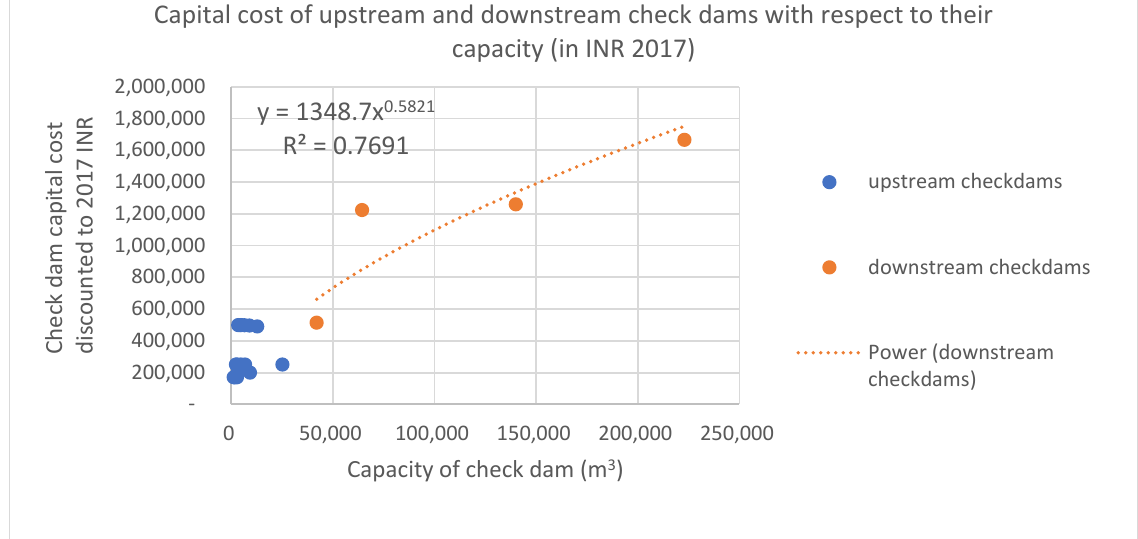
Figure 8. Capital costs of upstream and downstream check dams were compared discounted to 2017, the year of construction of upstream check dams. Costs are in Indian Rupees (INR).